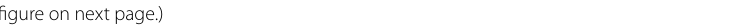
figure on next Fig. 8 CIH treatment did not significant influence the expression of PDP1/PDHA1 in hippocampus. A Nile Red staining of hippocampus. (Scale bar: 20 μm). B Quantification of LDs accumulation. C , D PDP1 and PDHA1 expression patterns were determined by RT-PCR. E – H Western blot assays were performed to determine the expression level of PDP1/PDHA1, and the gray value of the band was measured. I The PDC activity of hippocampus. J Total levels of acetyl-CoA in hippocampus. Each experiment was repeated three times. Data are shown as the mean Statistical analysis was performed with two-way ANOVA. *p < 0.05 WT group vs WT CIH group. Magnification: 400